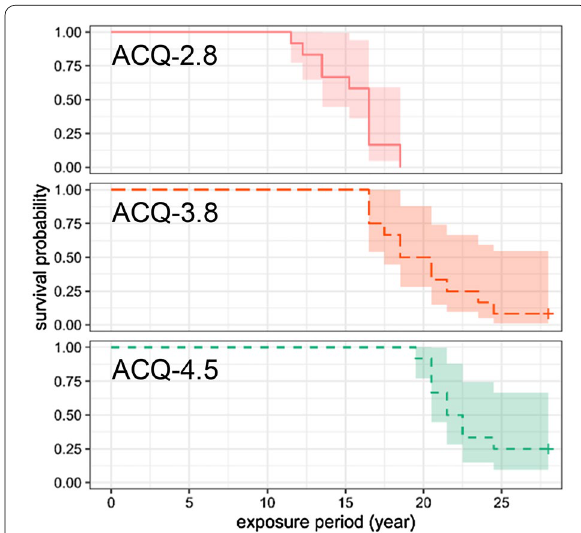
Fig. 4 Kaplan–Meier curves for stakes impregnated with ACQ-1 at different retention at the Nara site. Information on the stakes in each performance classification is shown in Table 1. ACQ-1 alkaline copper quaternary